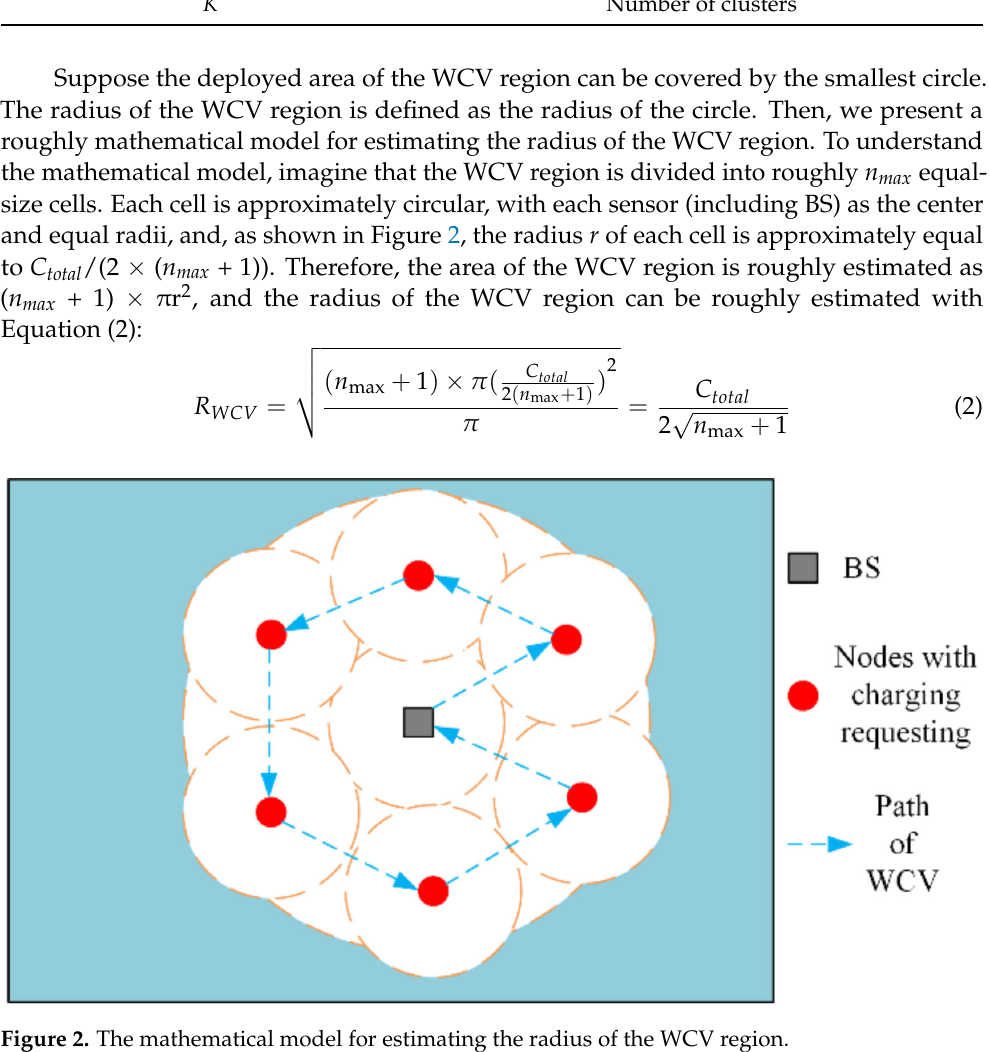
Figure 2. The mathematical model for estimating the radius of the WCV